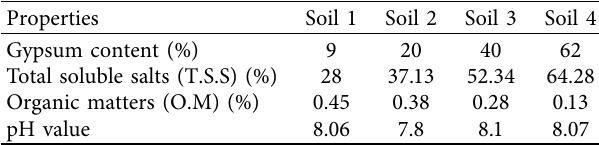
Table 1: Chemical properties of